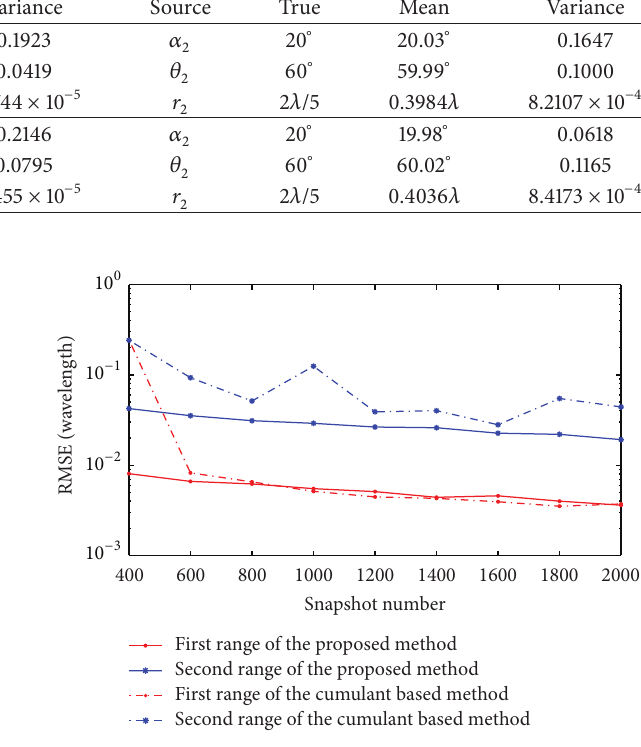
Figure 6: The RMSE of azimuth estimations for two near-field sourcesusingtheproposedmethodandthecumulantbasedmethod versus snapshot number.